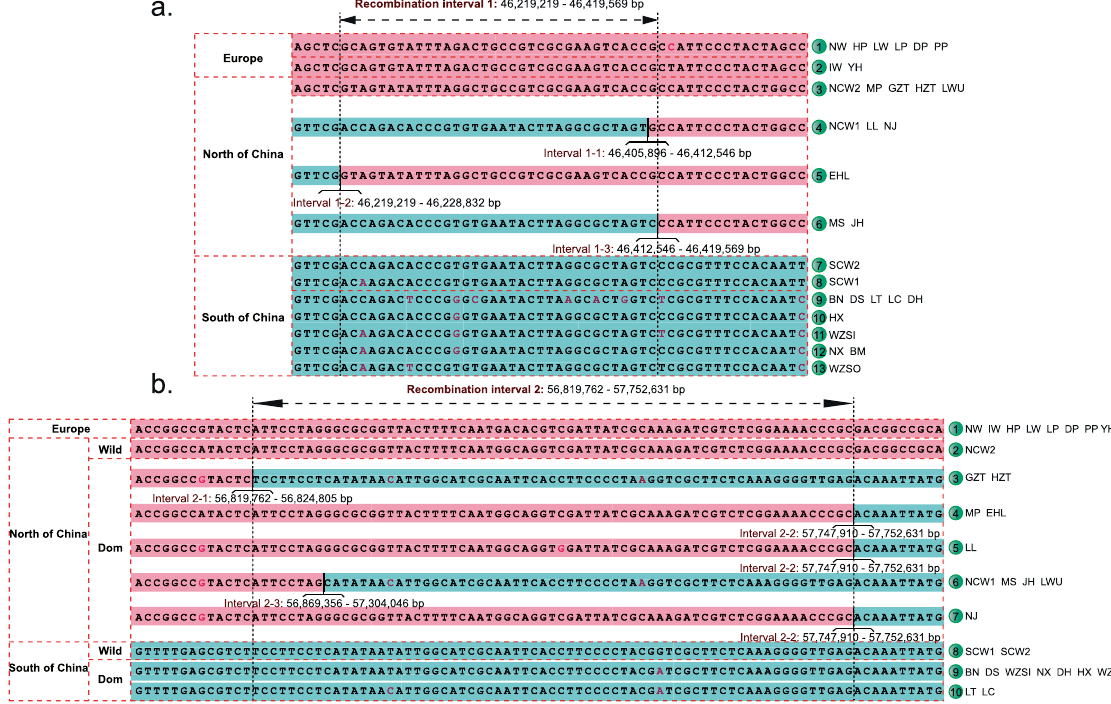
Figure 3. Physical location ranges of recombination interval 1 ( a ) and interval 2 ( b ) (The analysis used all SNPs in the LD block region). Red and blue represent the same or opposite alleles in the Wuzhishan reference genome, respectively. ( a ) Three types of recombination interval 1 (Interval 1-1, Interval 1-2, Interval 1-3) are identified in the domestic pigs of North China. The maximum range of recombination interval 1 is 46,219,219-46,419,569 bp. (b) Three types of recombination interval 2 (Interval 2-1, Interval 2-2, Interval 2-3) are identified in the domestic pigs of North China. The maximum range of recombination interval 2 is 56,819,762-57,752,631